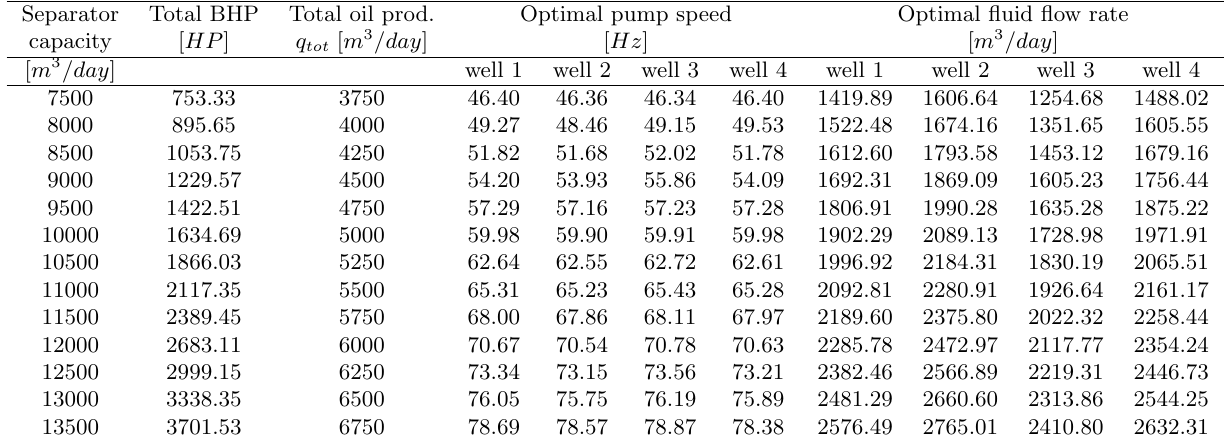
Table 2: Optimal operation of ESP oil field for different separator capacities for case II